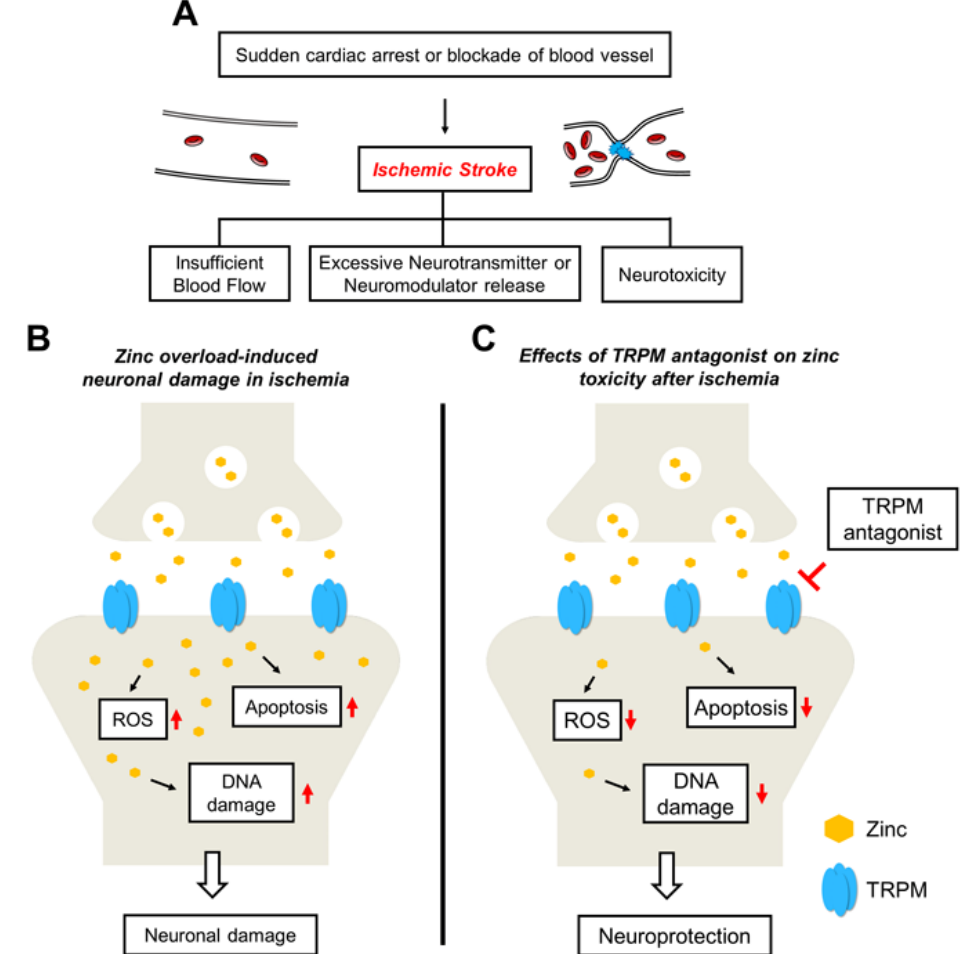
Figure 1. Proposed cascades for the neuroprotective effects of TRPM antagonists on global cerebral- ischemia-induced neuronal death. ( A ) The main cause of brain ischemia is drastically halted blood flow and the blockage of blood vessels. Deleterious mechanisms following brain ischemia are neurotoxicity, glutamate excitotoxicity, and zinc overload. ( B ) A schematic drawing illustrating the possible cascades via ischemia that can induce neuronal damage. Zinc that is excessively released from pre-synaptic vesicles and accumulated through the TRPM channel can trigger ROS production, thereby damaging the apoptotic pathway and DNA. Consequently, this accumulation can contribute to neuronal damage. ( C ) Possible neuroprotective properties of TRPM antagonists. Reduced post- synaptic zinc entering through the TRPM channel via antagonists can reduce neuronal